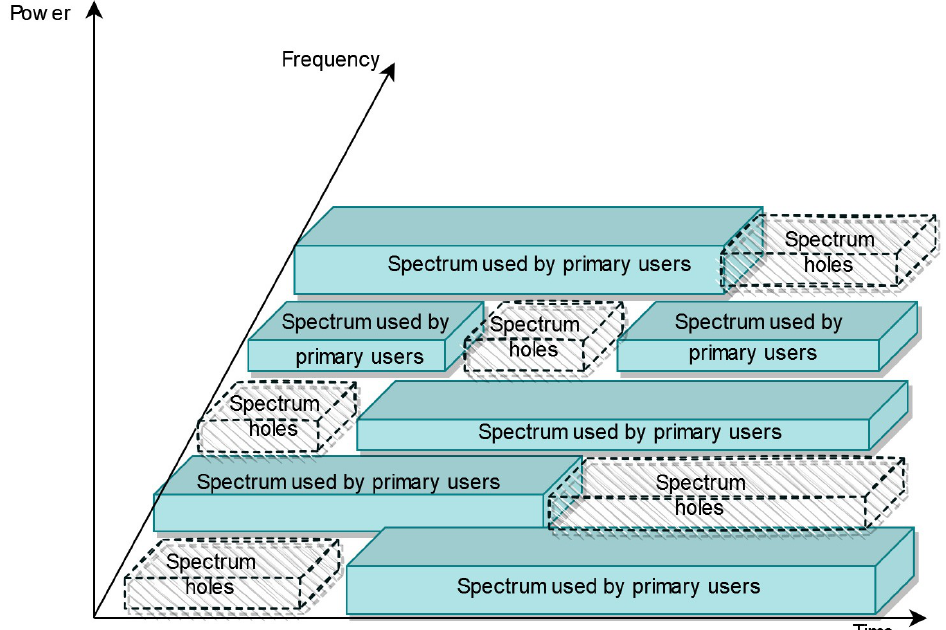
Figure 1. Spectrum holes: The CR user is able to access the available channels and is obliged to avoid the occupied ones in order to minimize the interference